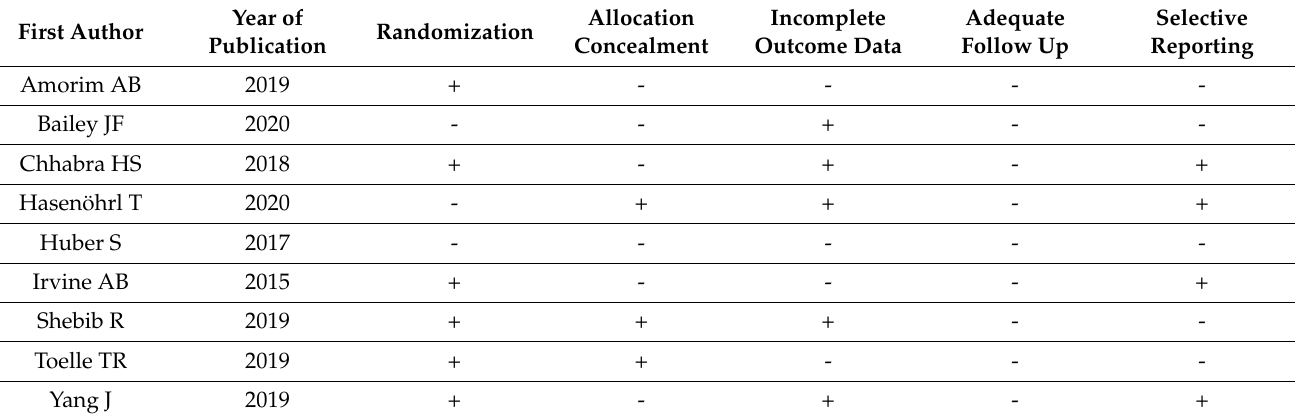
Table 1. Quality assessment results using the risk-of-bias assessment